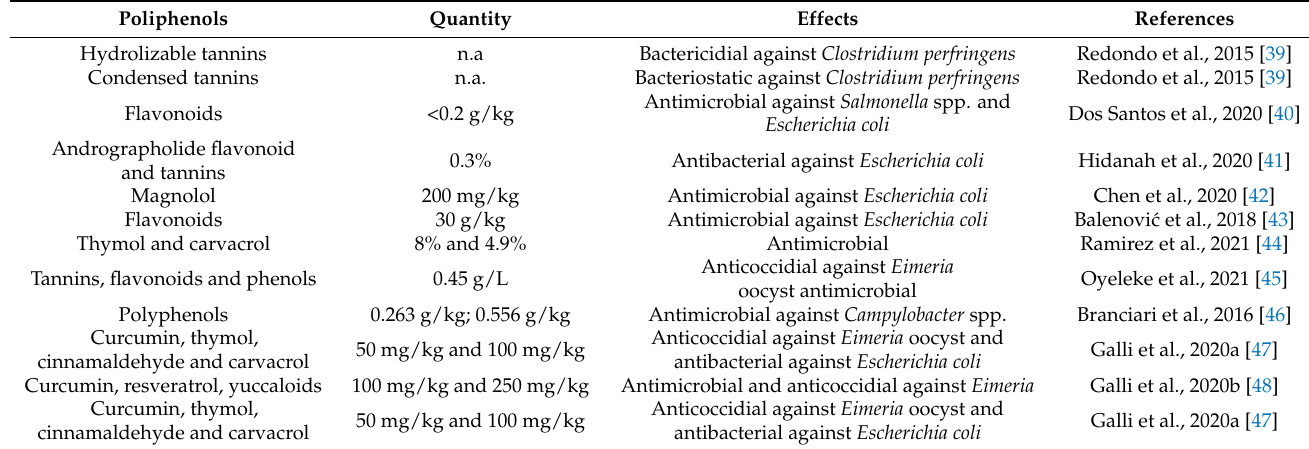
Table 1. Example of polyphenols studied as